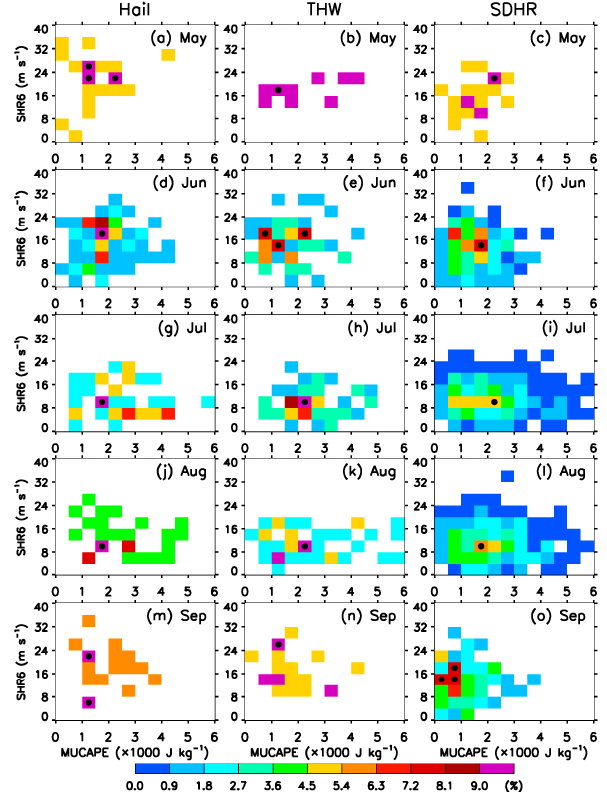
Figure 12. Same as Figure 11, but for severe convective events over the plains. Panels ( a , d , g , j , m ) represent hail events, ( b , e , h , k , n ) represent THW events, and ( c , f , i , l , o ) represent SDHR events. Panels ( a – c ), ( d – f ), ( g – i ), ( j – l ), and ( m – o ) represent events that occur in May, June, July, August, and September,